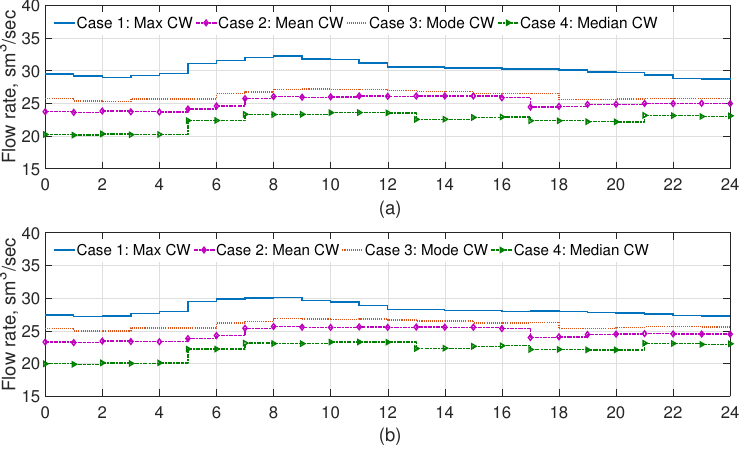
Figure 11. ( a ) Pipe 10 flow rate of blended gas with H 2 , ( b ) Flow rate in Pipe 10 without